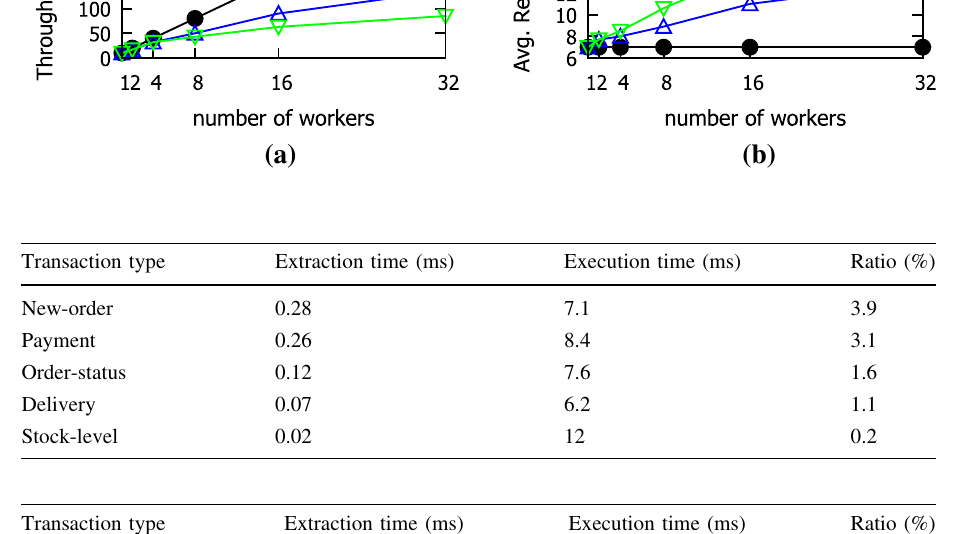
Table 2 Execution time (ms) spent on reordering block extraction on TPC-E